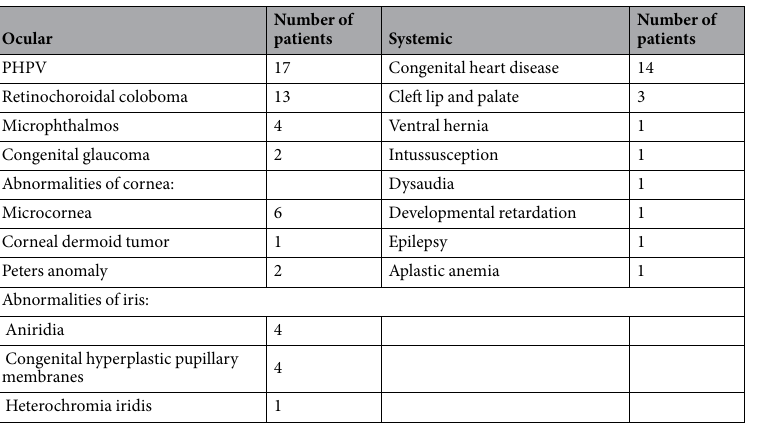
Table 3. Congenital ocular and systemic abnormalities associated with congenital/developmental cataracts. Values are presented as